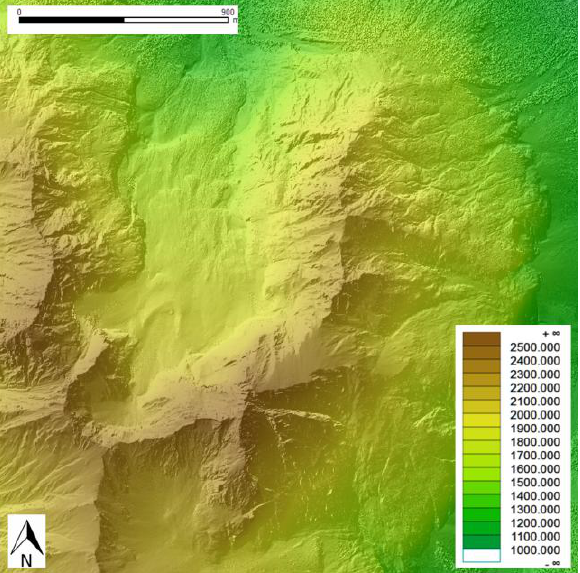
Figure 9. DSM of data set 2; elevation coding overlayed with hill shading; data: Province of